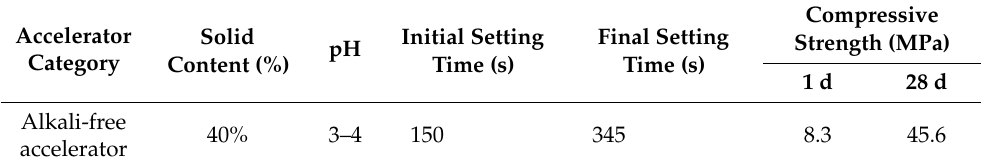
Table 3. Physical and chemical indexes related to the accelerator performance.